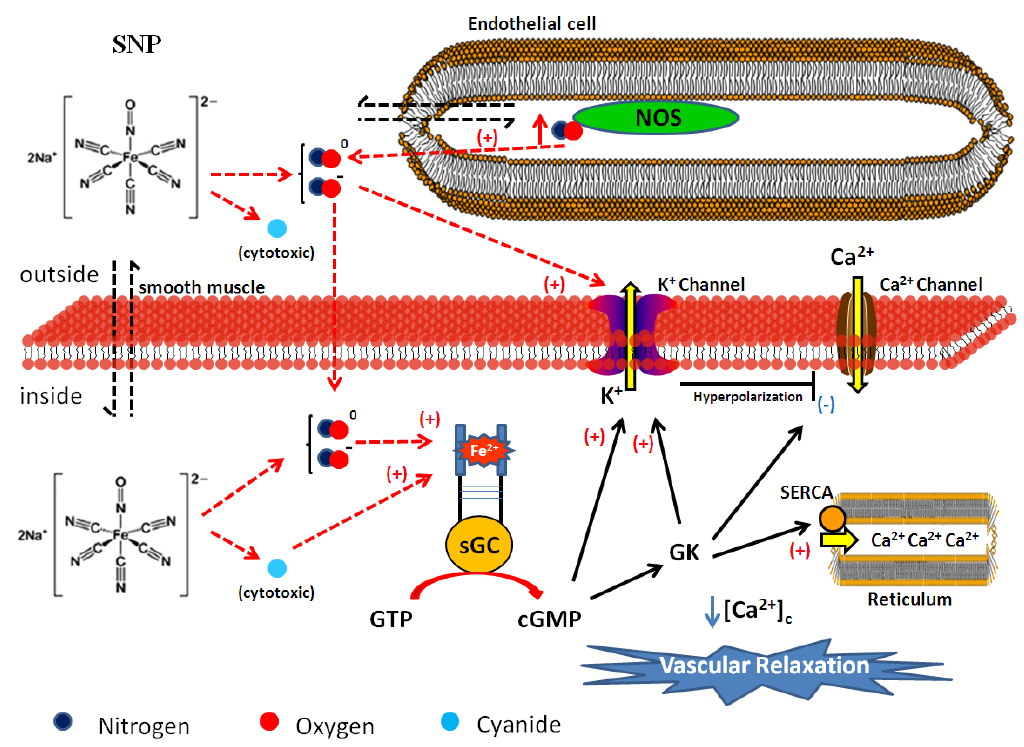
Figure 1. Proposed nitric oxide release and vasodilating mechanism prompted by sodium nitroprusside (SNP). The colored circles represent atoms in the chemical structure. Legend: NOS = Nitric Oxide Synthase, sGC = soluble guanylyl cyclase, GK = G Kinase Protein, SERCA = sarco/endoplasmic reticulum calcium-ATPase, Ca 2+ = calcium, K + = potassium, = cytosolic calcium [Ca 2+ ] c